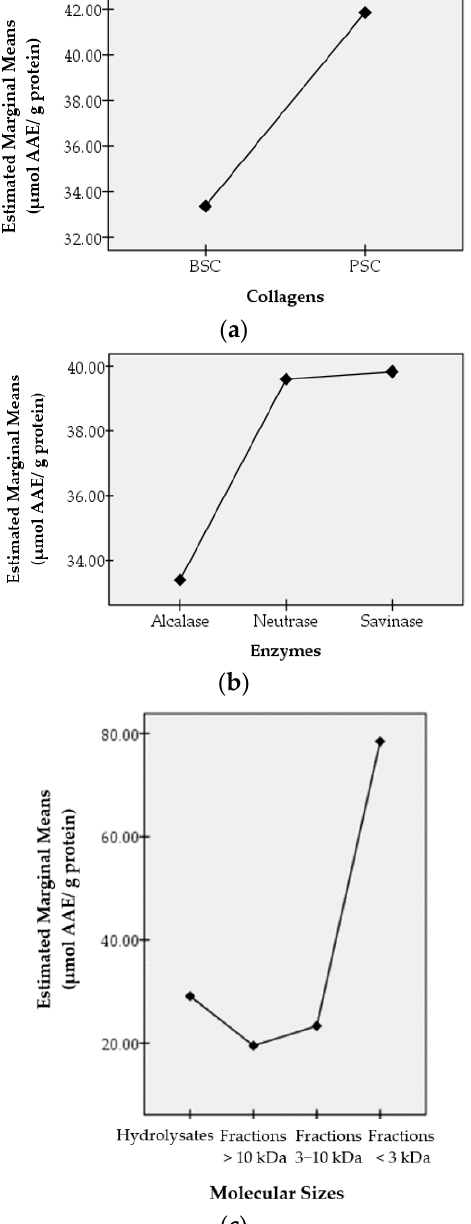
Figure 3. Profile plots of factors influencing the antioxidant activity of hydrolysates and peptide fractions of bigeye tuna skin collagen. The X-axis shows the type of collagen ( a ), the type of enzyme ( b ), and the size of the molecule ( c ). The Y-axis shows the estimated marginal average value (in µ mol AAE/g